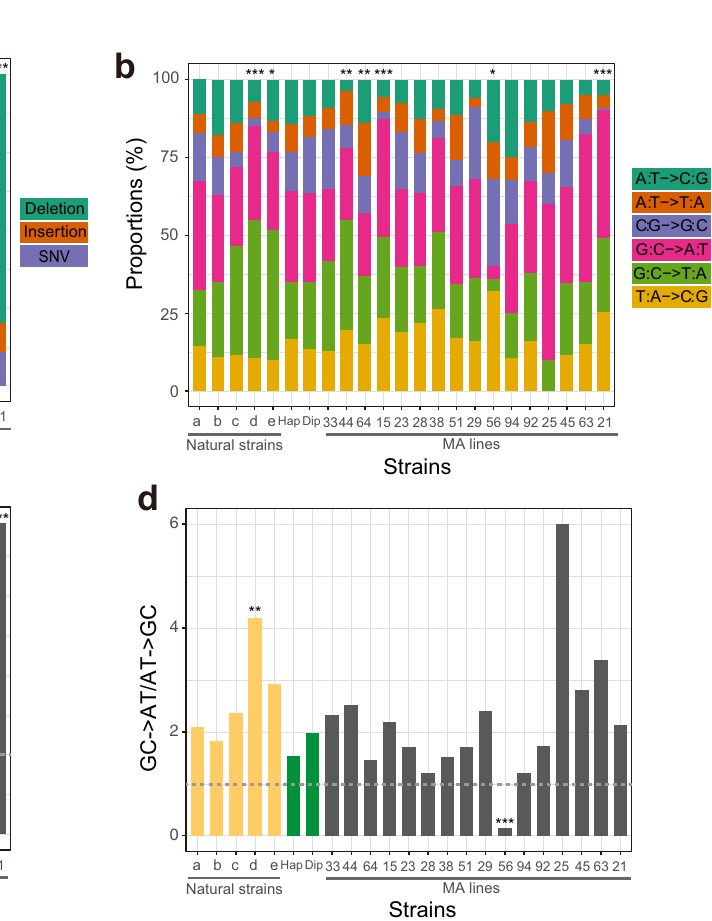
letters on the X-axis refer to natural strains (a DBY4974/DBY4975; b SEY6211; c SK1/BY; d DBVPG6765; and e YPS128/DBVPG6765), “ Hap ” refers to the progenitor in the haploid form, “ Dip ” refers to the pro- genitor in the diploid form, and the numbers refer to IDs of MA lines. Two-tailed chi-squared test is performed between each strain and the progenitor: *, P < 0.05; **, P <0.01; ***, P <0.001.